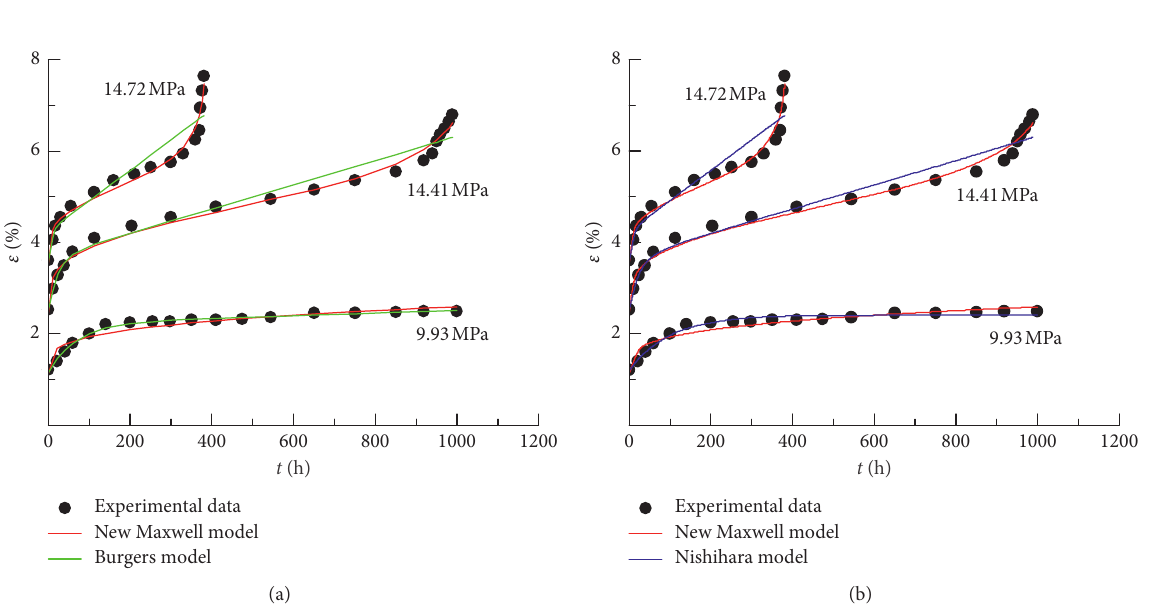
Figure 5: Comparison between theoretical and experimental curves of (a) new Maxwell model and Burgers model and (b) new Maxwell model and Nishihara